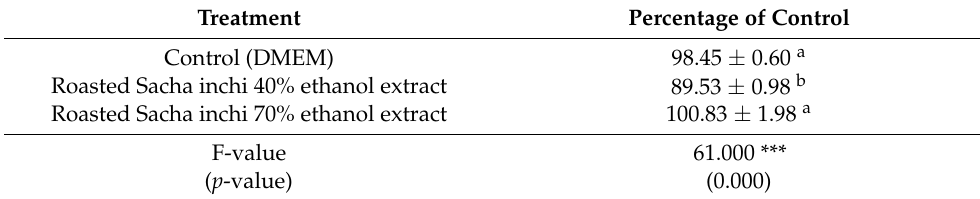
Table 3. Analyzed HT22 cell viability after 24 h according to extractant concentration for roasted Sacha